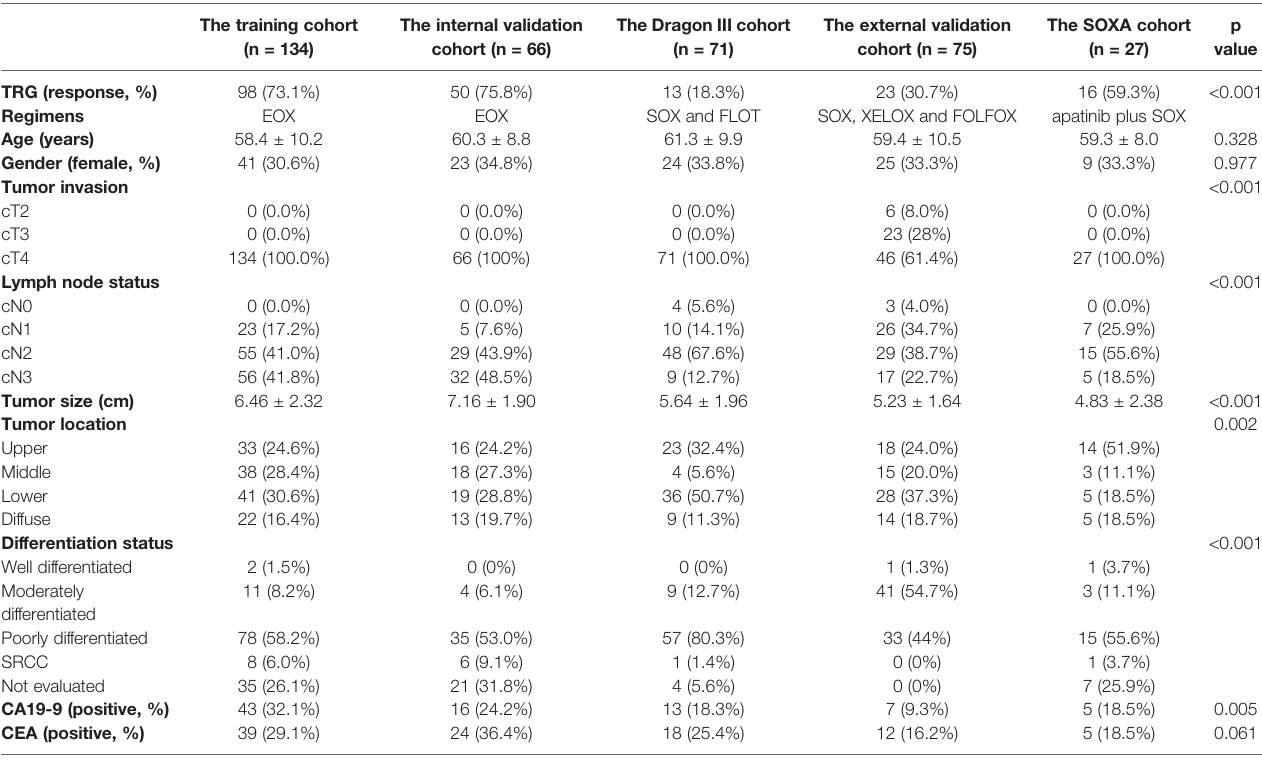
TABLE 1 | Demographic data for all patients in each